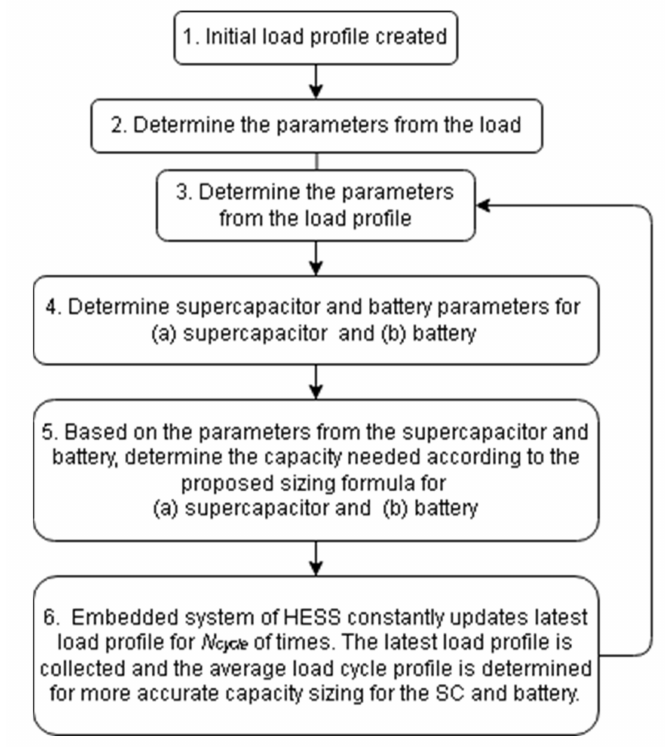
Figure 3. Flowchart for the proposed sizing